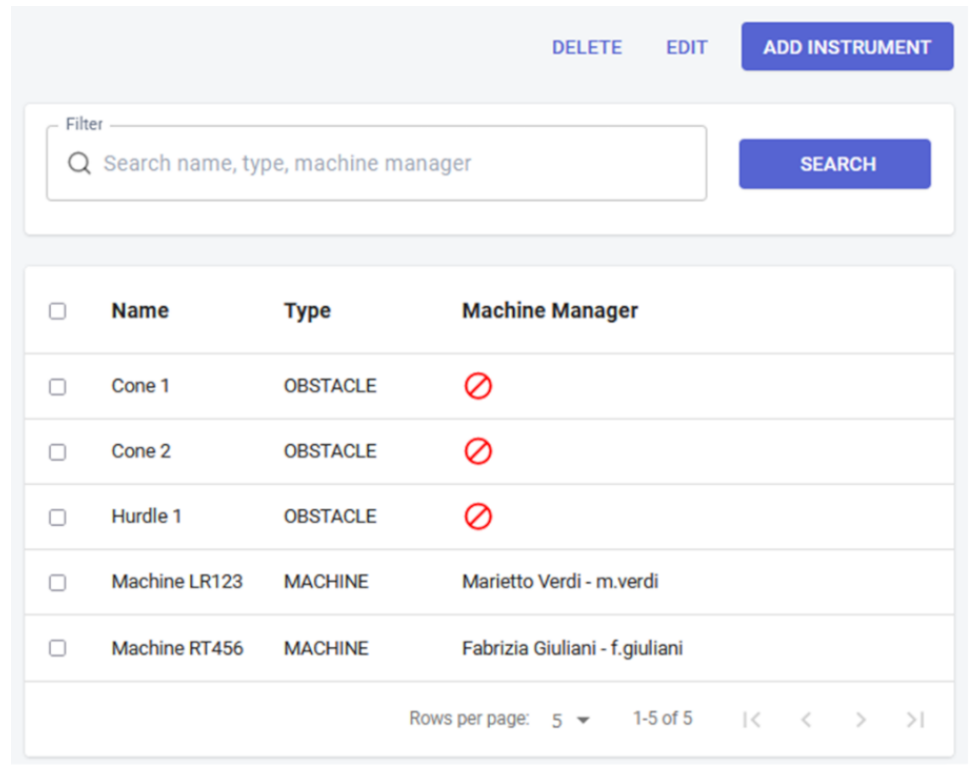
Figure 16. Instrument tab of the Front-end application.